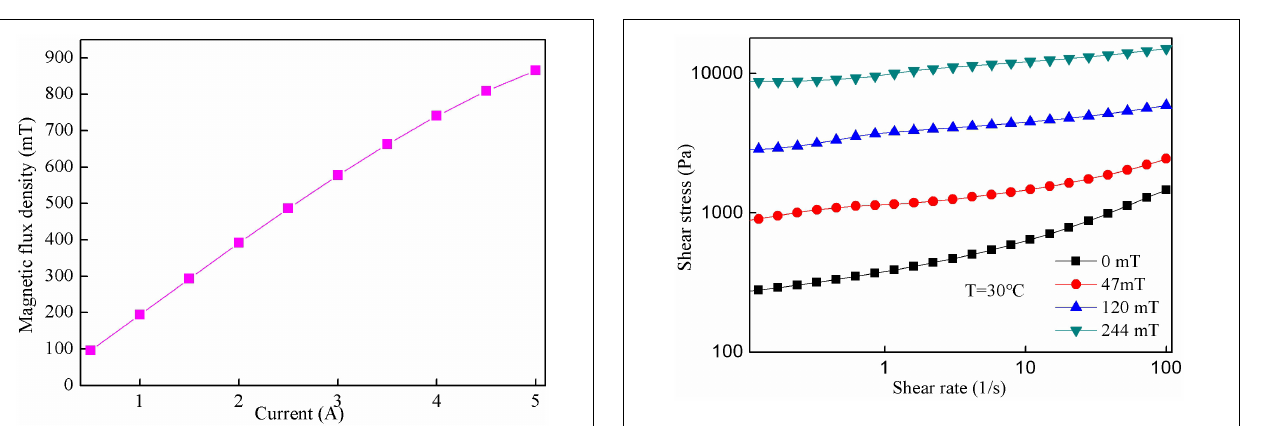
FIGURE 4 | The relationship between current and magnetic flux density.